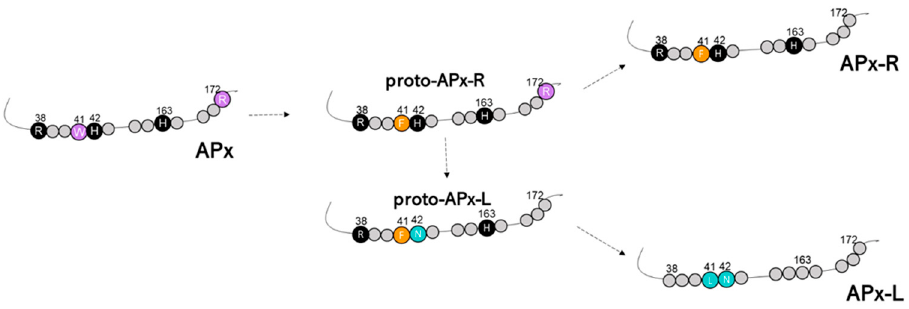
Figure 7. The proposed model to explain the origin of APX-R and APX-L. Relevant residues are represented based on angiosperms sequences, and their position is discriminated. Conserved amino acids are indicated and coloured according to the group they are primarily found. Amino acid